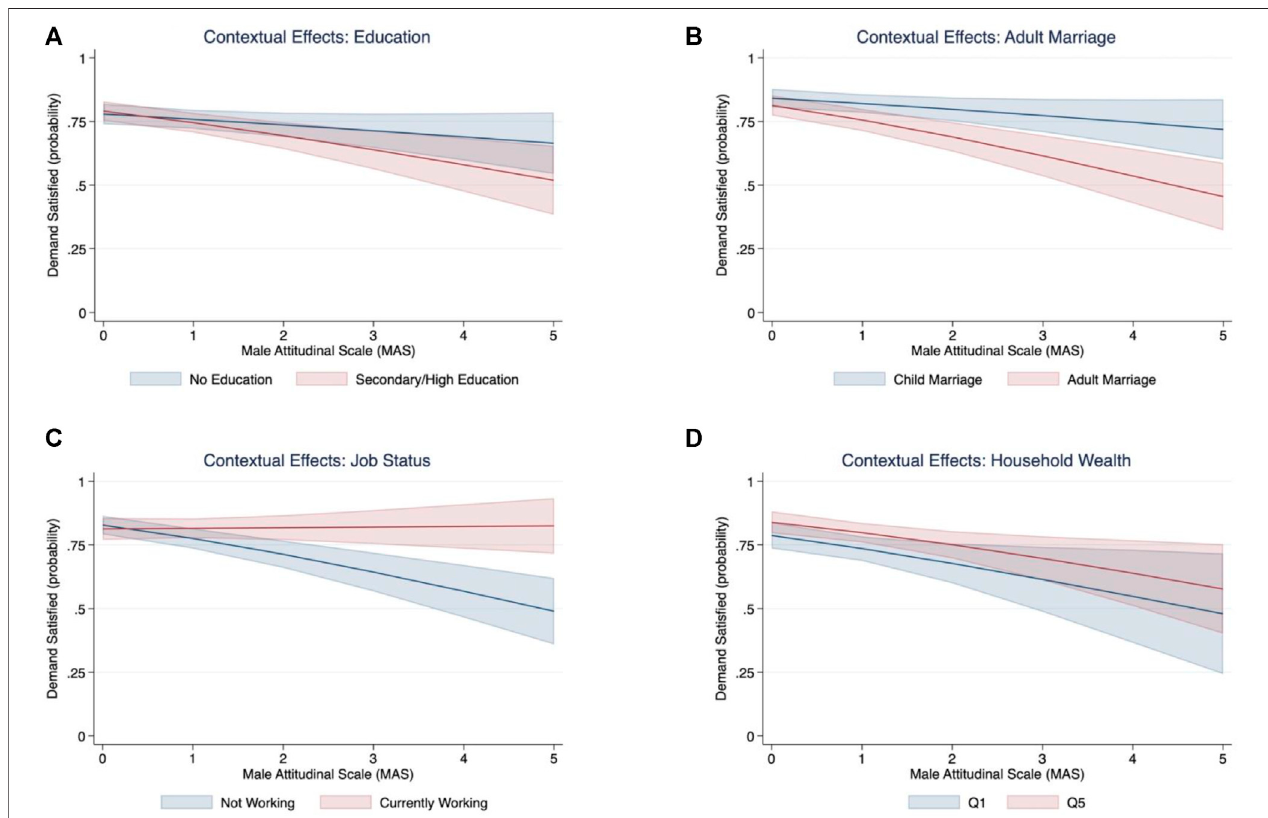
FIGURE4| Contextualeffectsassociationsbetweenmen ’ sattitudinalnormsandwomen ’ sempowerment( (A) Education, (B) AdultMarriage, (C) JobStatus),and Household Wealth (D) . Note: Q1 and Q5 stand for the wealth quintiles 1 and 5, respectively.